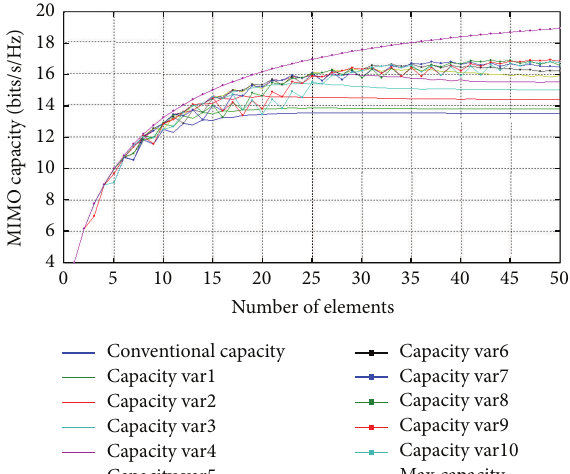
Figure 13: MIMO capacity for the spiral geometry with a SNR = 15dB and a radius of 0.5 𝑑